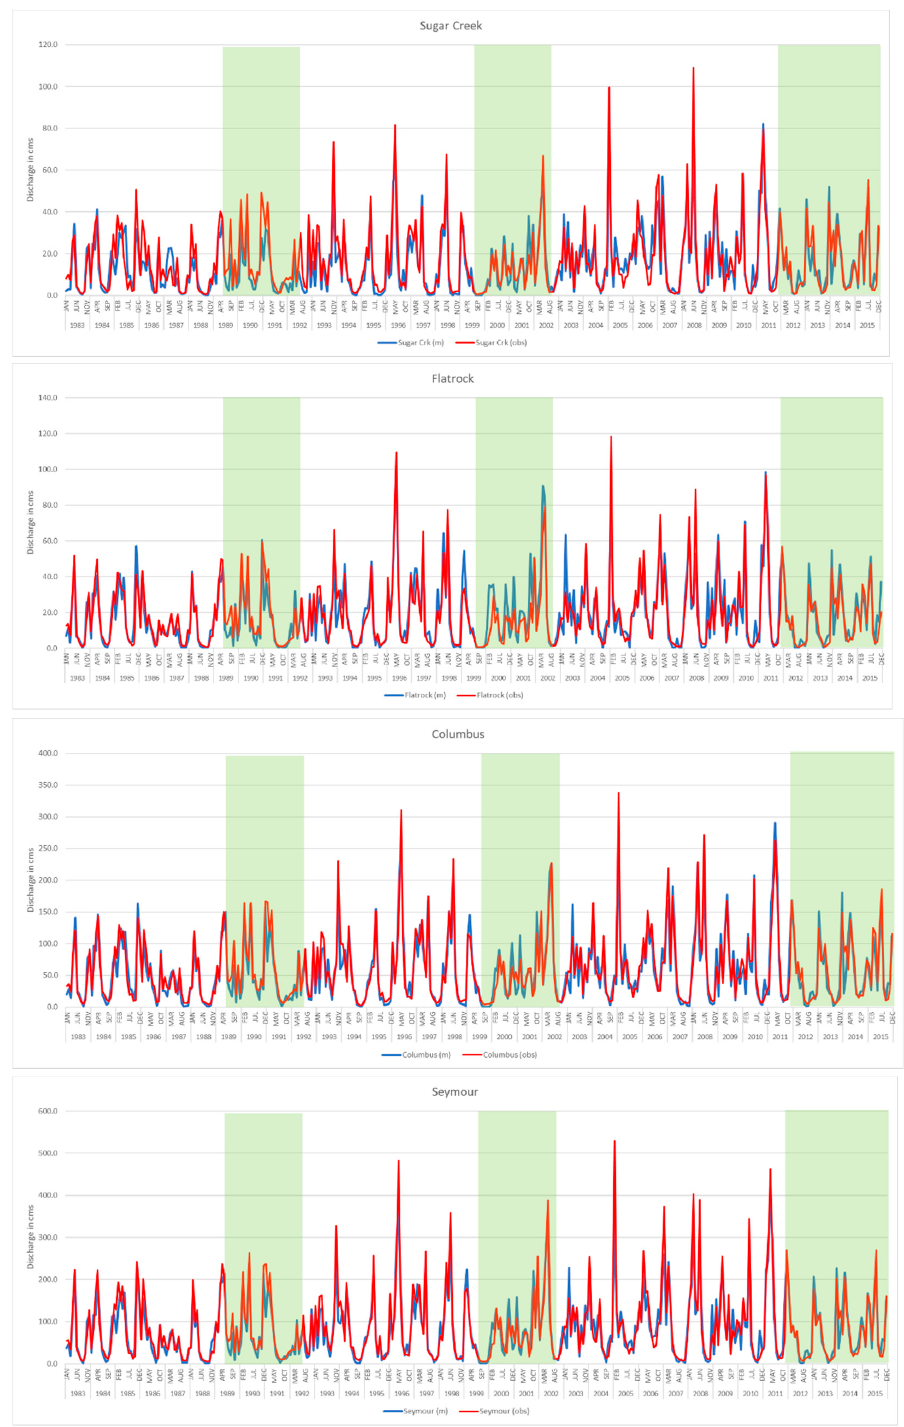
Figure 6. Monthly discharge (in m 3 /s) timeseries of observed ( red ) and modeled ( blue ) outputs for Sugar Creek, Flatrock, Columbus, and Seymour (outlet) monitoring sites. With light green are highlighted the intermediate validation time range among the different configuration periods.